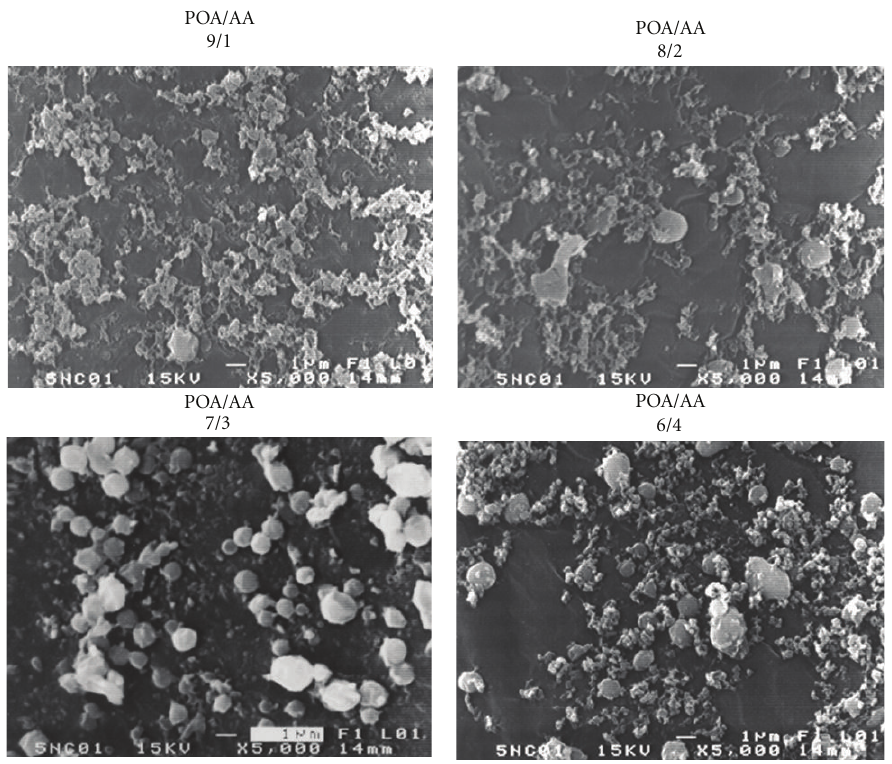
Figure 2: SEM images of the polymer particles obtained from the copolymers in scCO 2 at 45 ◦ C and the cloud point pressure − 300 psi.